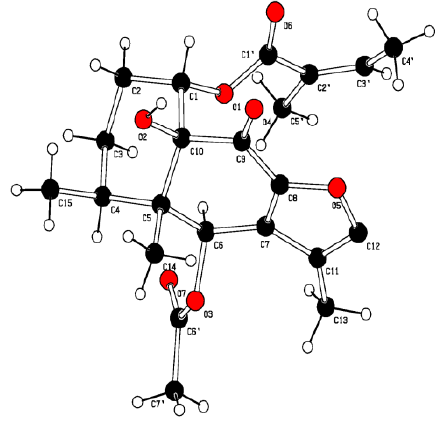
Figure 3. NOESY and ORTEP of compound 1.